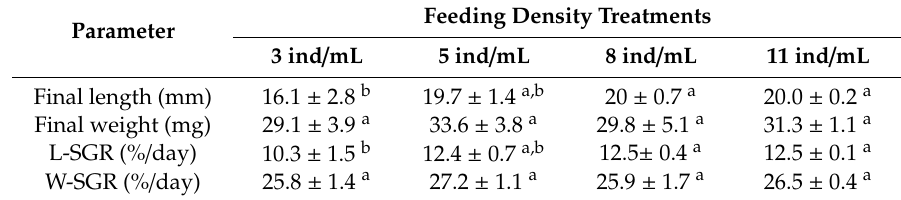
Table 5. Growth performance of P. hypophthalmus larvae after 10 days of development under di ff erent feeding density